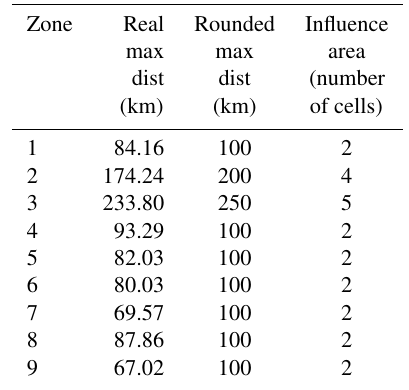
Table 2. Size of the influence area for the localization